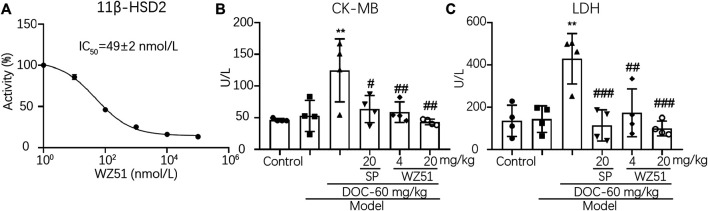
WZ51 significantly reduced myocardial injury in renal hypertensive rats. (A). Inhibition of 11β-HSD2 by different concentrations of WZ51. (B, C). Serum LDH and CK-MB of each group was determined using Creatine kinase MB isoenzyme Assay Kit and Lactate dehydrogenase assay kit following the recommended protocol (**p < 0.01 vs. CON; #
p < 0.05, ##
p < 0.01, ###
p < 0.001 vs. DOC; n = 4). U/L = unit/L.